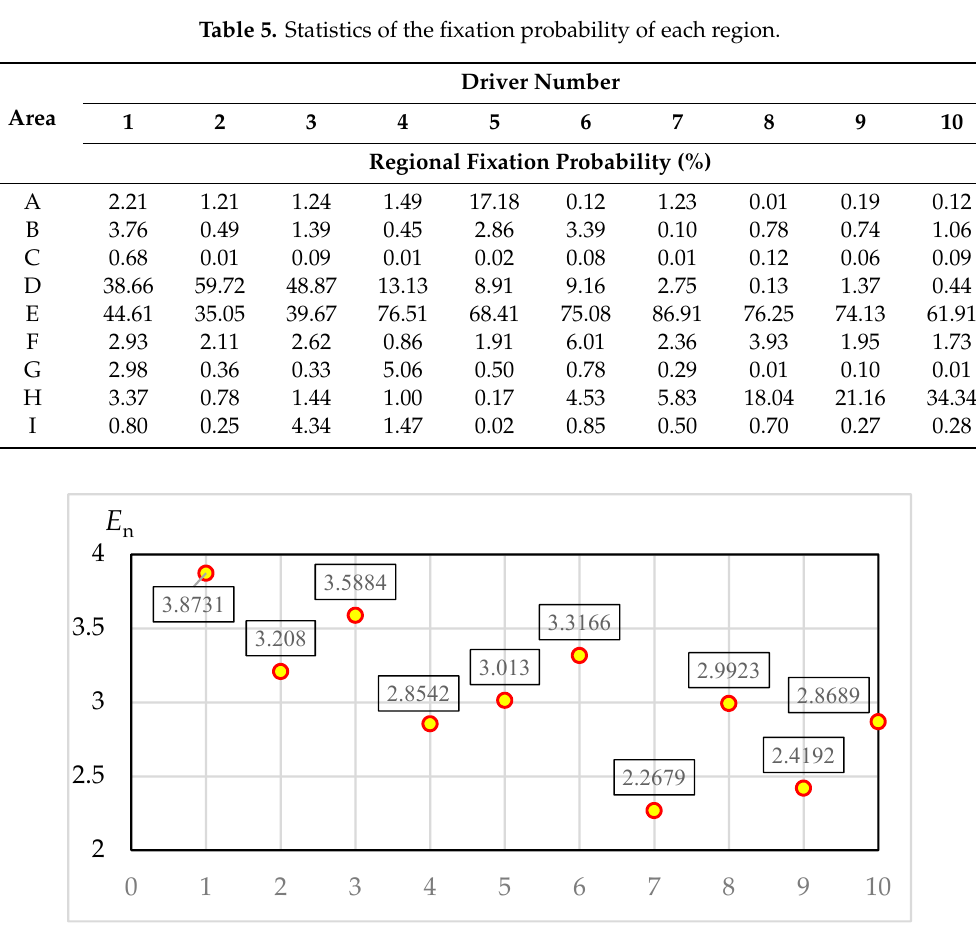
Figure 5. Fixation entropy value of each driver.